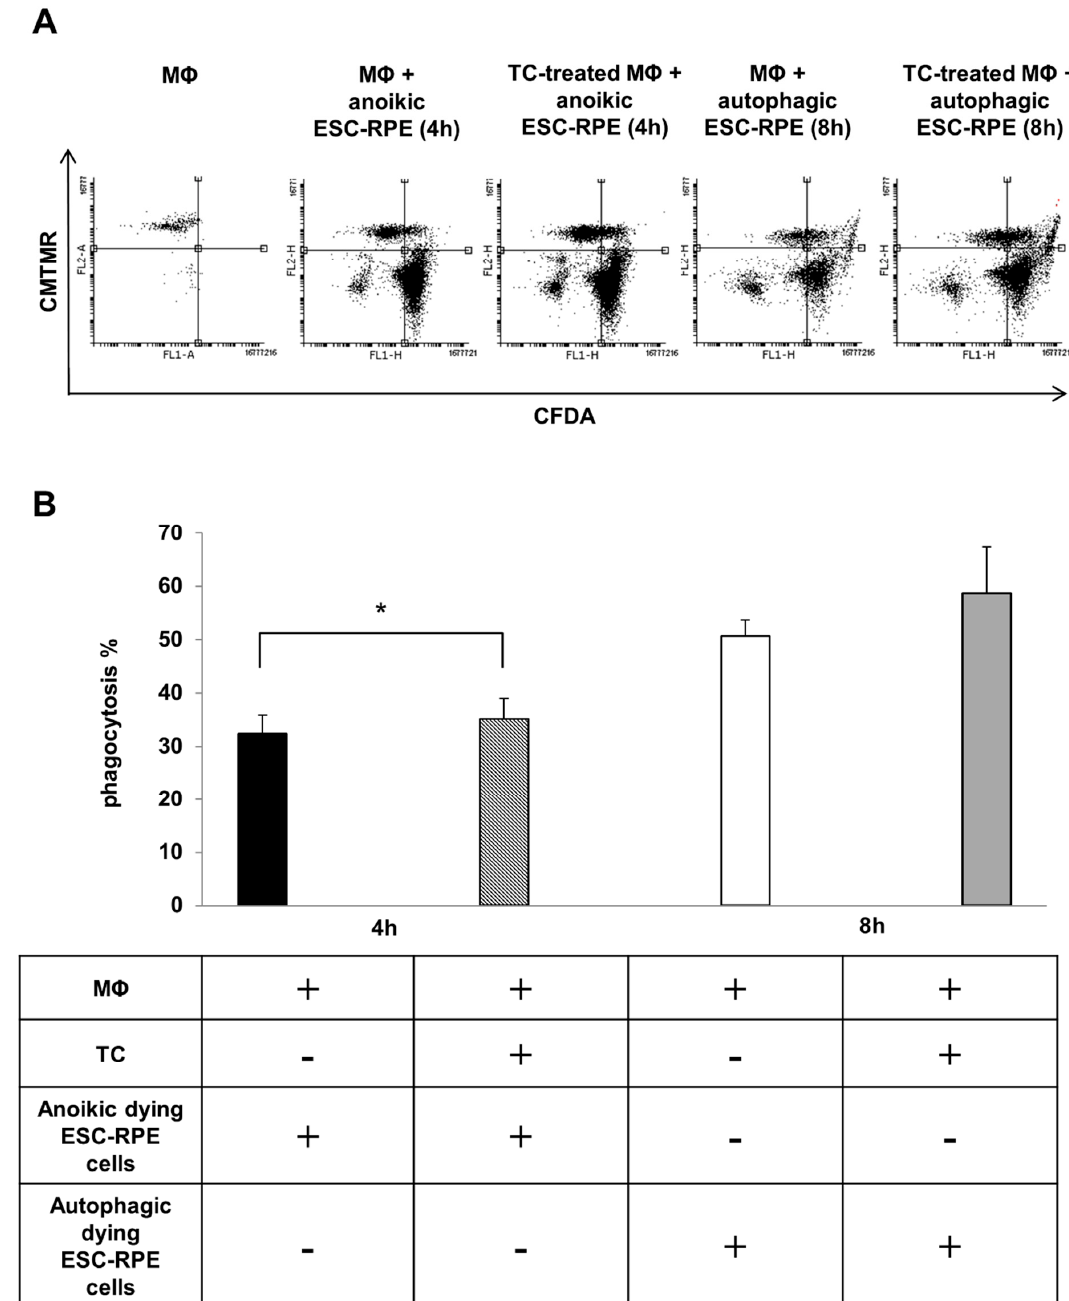
Figure 4. The clearance of anoikic and autophagy-associated dying hESC-RPE cells by macrophages. ( A ) Representative flow cytometry dot plots demonstrating phagocytosis of anoikic and autophagy- associated dying hESC-RPE cells by macrophages after 4 h and 8 h co-incubation, respectively. Macrophages were pre-treated with 1 µ M triamcinolone (TC) for 48 h. The horizontal axis represents the intensity of staining for CFDA (log scale) and the vertical axis shows the intensity of staining for CMTMR (log scale). Cells in the upper right quadrant indicate the engulfed hESC-RPE (CFDA-labeled) cells by macrophages (CMTMR-labeled). Data are representative of 3 independent experiments. ( B ) The phagocytosis rate of anoikic and autophagy-associated dying hESC-RPE cells by untreated and TC-pre-treated (48 h, 1 µ M) macrophages after 4 h and 8 h co-incubation, respectively, is shown as determined by flow cytometry analysis. Bars represent the mean ± SD of 3 independent experiments, * p <